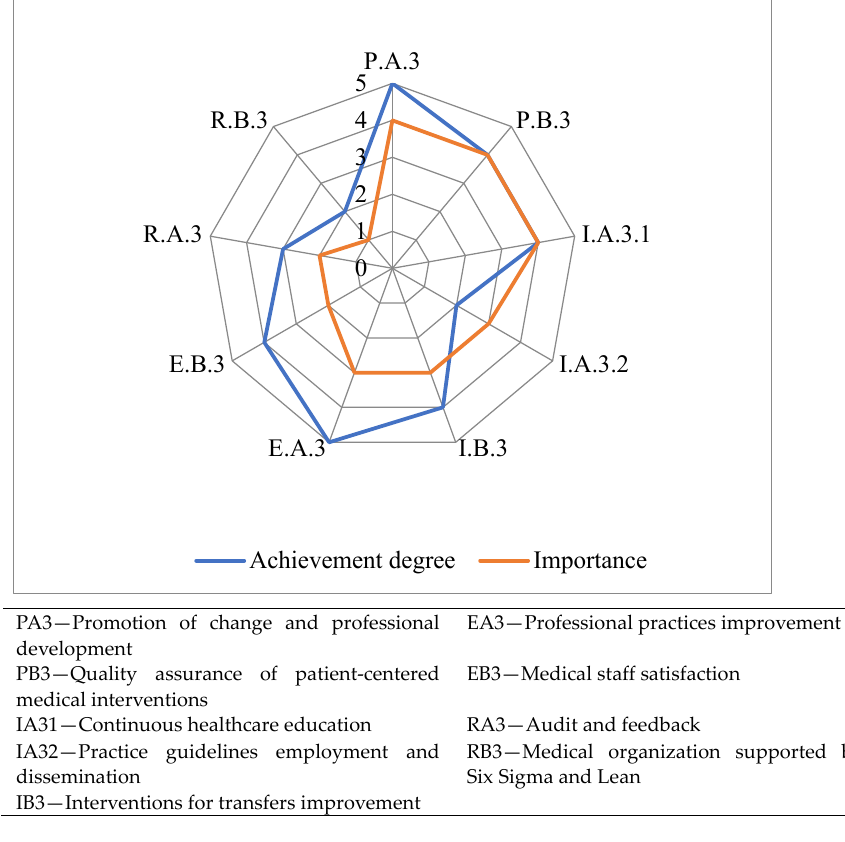
Figure 5. Labor practices sustainability evaluation graph.